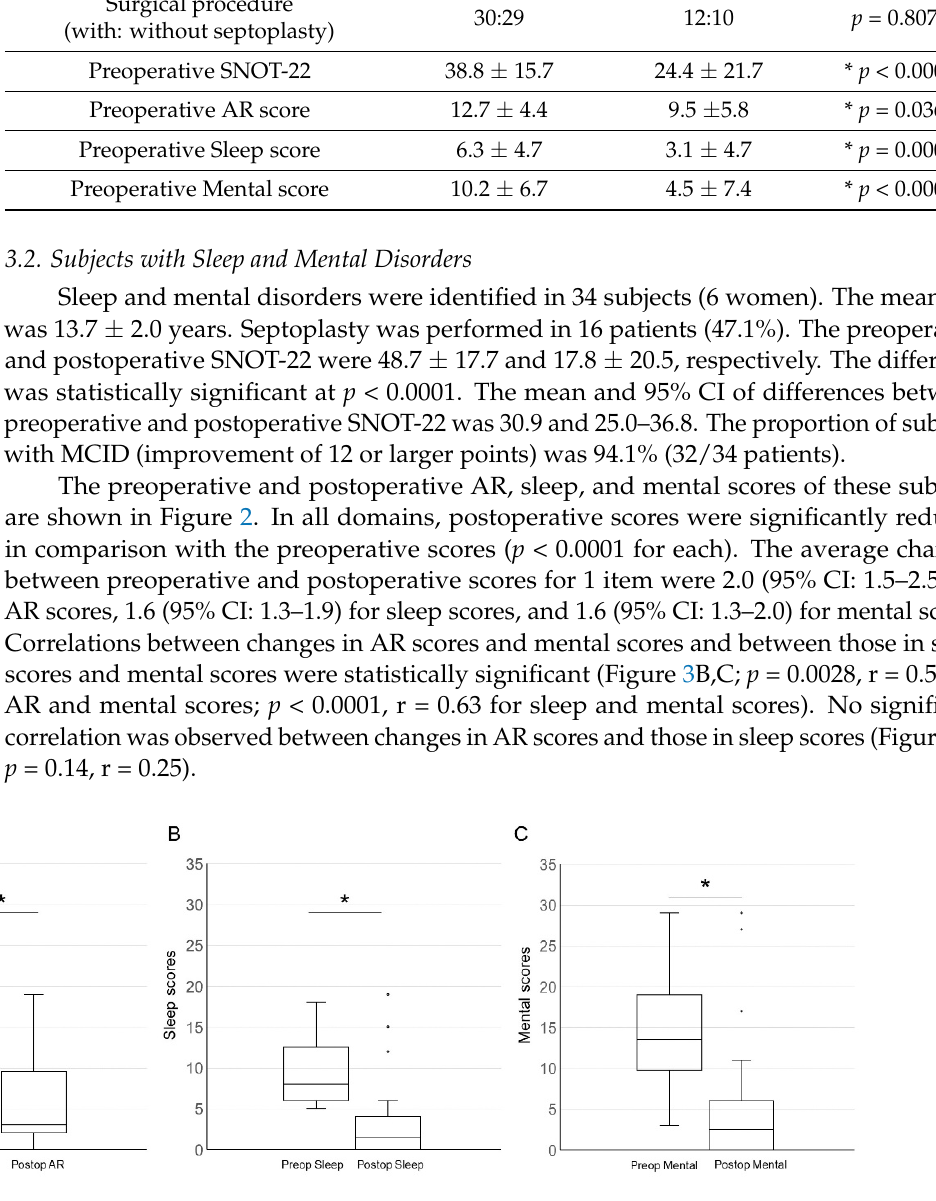
Figure 2. Box plots of preoperative and postoperative AR ( A ), sleep ( B ), and mental scores ( C ) in patients with both sleep and mental disorders. Differences between the preoperative and postoperative scores for each parameter were statistically significant at p < 0.0001 using the Wilcoxon rank test (*).